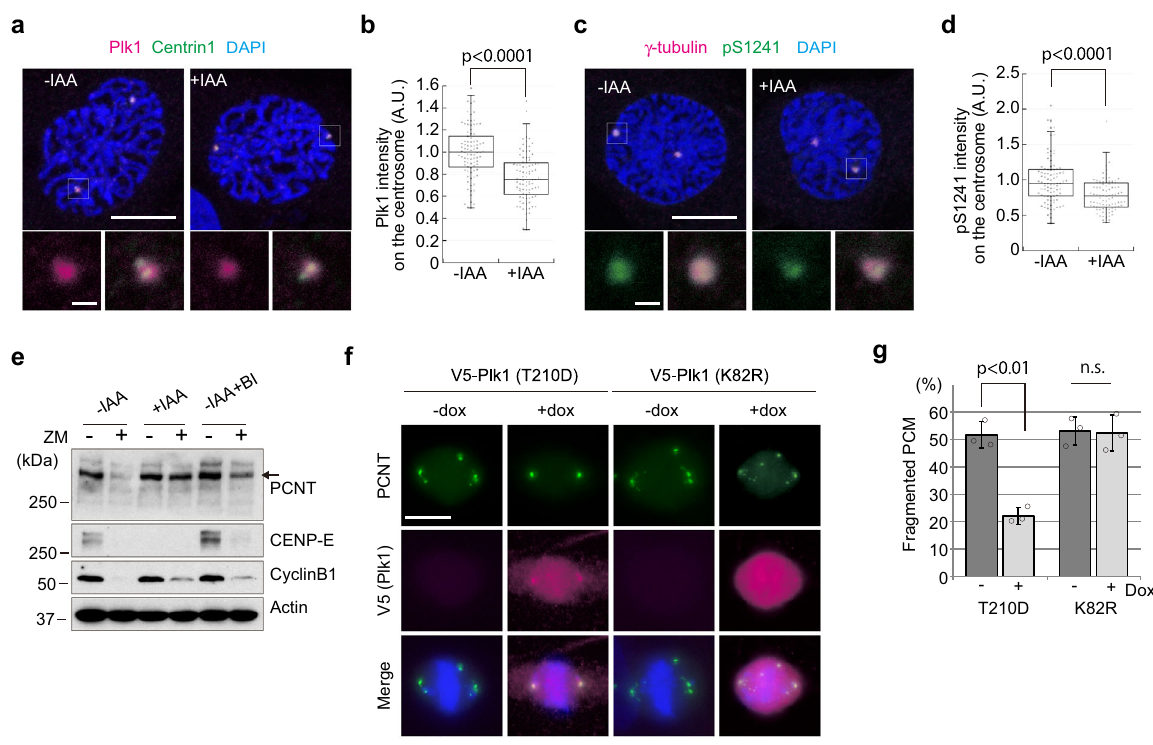
Fig. 5 PCM1 fragmentation in CENP-E KO results from reductions in centrosomal Plk1 levels and aberrant phosphorylation of PCNT. a , b Representative images for IAA-treated or un-treated CENP-E-AID cells in prophase co-immunostained with antibodies against Plk1 (magenta) and centrin1 (green; a , scale bar = 10 μ m). The area enclosed by the square in each image is magni fi ed and shown under the panel (scale bar = 1 μ m). Relative Plk1 intensities on the centrosome in prophase cells were plotted in b ( N = 90, three independent experiments; whisker: 95% con fi dence interval; box: interquartile; center line: median). c , d Representative images for IAA-treated or untreated CENP-E-AID cells in prophase co-immunostained with antibodies against γ -tubulin (magenta) and PCNT-pS1241 (green; c , scale bar = 10 μ m). The area enclosed by the square in each image is magni fi ed and shown under the panel (scale bar = 1 μ m). Relative PCNT-pS1241 intensities on the centrosome in prophase cells were plotted in d ( N = 90, three independent experiments; whisker: 95% con fi dence interval; box: interquartile; center line: median). e Control ( − IAA), CENP-E KO ( + IAA), and Plk1 inhibited ( − IAA + BI) cells synchronized with 100 nM paclitaxel were shaken off from plates and forced to exit from mitosis with 2 μ M ZM44739 for 1 h. Cell lysates were immuno-blotted with indicated antibodies. The arrow indicates full-length PCNT. f , g CENP-E-AID cell lines stably expressing doxycycline (dox)-inducible V5-tagged Plk1 (T210D: constitutively active; K82R: catalytically inactive) were synchronized with thymidine for 22 h, and released for 8 h. The cells were stained with antibodies against V5-tag (magenta) and PCNT (green). In + dox samples, 1 μ g/ml dox was maintained throughout the experiments. Representative images for metaphase cells in each sample are shown ( f , scale bar = 10 μ m). Percentages of metaphase cells with fragmented PCM are compared in g (>100 cells in total from three independent experiments; error bars: SD). p -values were calculated by Mann – Whitney U tests ( b , d ) or an unpaired t -test ( g